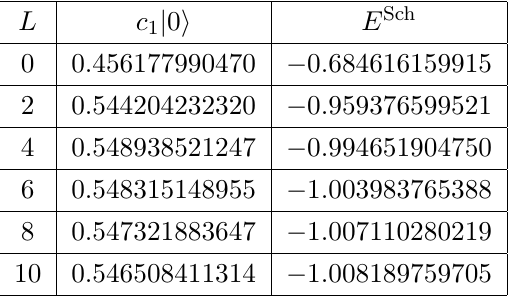
Table 2 . ( L; 3 L ) level-truncation results for the tachyon vev and vacuum energy in Schnabl